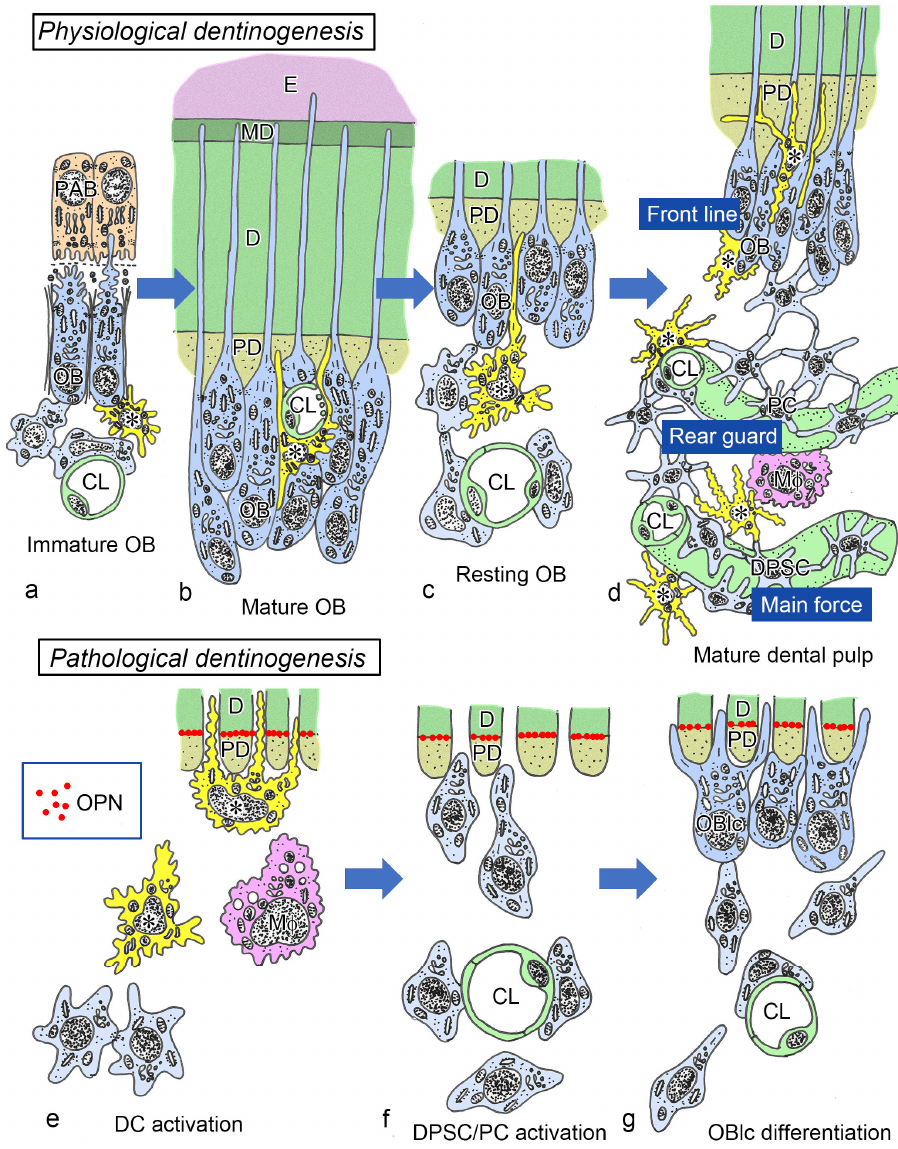
Figure 8. Schematic views summarizing the possible role of DCs (*) during physiological and pathological dentinogenesis. Osteopontin (OPN) is not, but the enamel epithelium and basement membrane are necessary for the odontoblast (OB) differentiation during physiological dentinogenesis. Odontoblasts are classified into immature ( a ), mature ( b ), and resting odontoblasts ( c ), and DCs associate with the odontoblasts in this process. Mature dental pulp ( d ) is composed of the frontline including odontoblasts, the rearguard including progenitor cells (PC), and the main force including dental pulp stem cells (DPSCs), and DCs associate with all compartments. OPN is deposited at the dentin-predentin interface during pathological dentinogenesis. OPN and DCs play a role in the sequential steps of DC activation ( e ), dental pulp stem/progenitor cell activation ( f ), and odontoblast-like cell (OBlc) differentiation ( g ). CL capillary lumen, D dentin, E enamel, MD mantle dentin, M φ macrophage, PAB preameloblast, PD predentin.